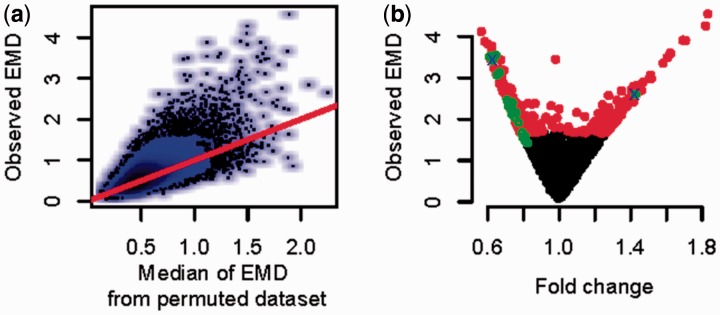
Performance of EMDomics for identifying genes associated with drug resistance in ovarian cancer. (a) Scatter plot of the median of permuted EMD values versus observed EMD values for the TCGA dataset. Black dots represent genes. The red line has a slope of 1 and passes through the origin. (b) EMD score versus fold change for TCGA dataset; red dots are significant genes with q-value < 0.05 using EMDomics, green circles are significant genes with q-value < 0.05 using SAM, and blue crosses are significant genes with adjusted p-value < 0.05 using Limma